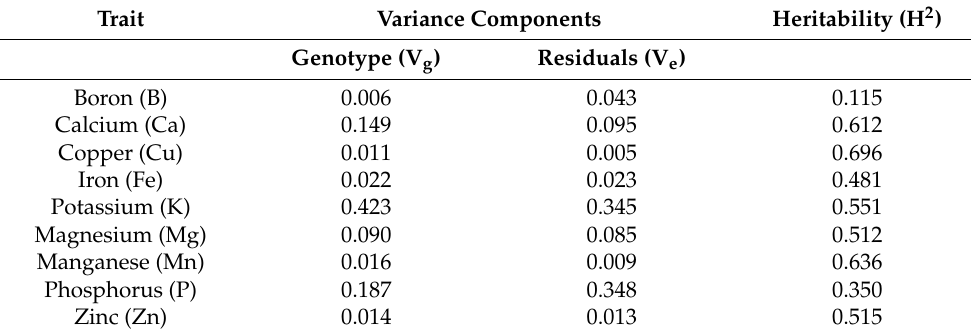
Table 1. Nutrient